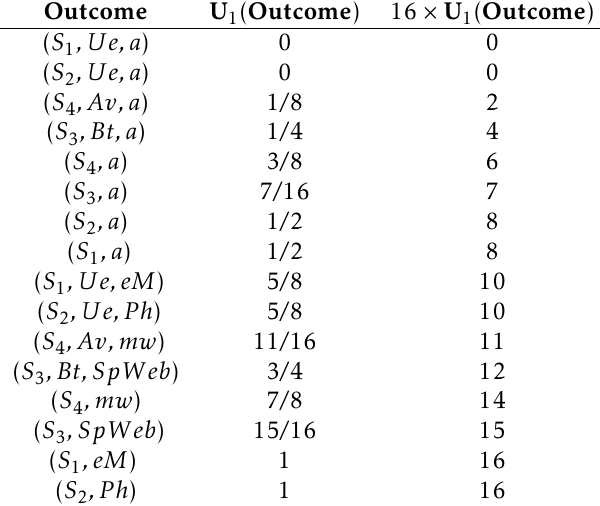
Table 3. Utility function for defender